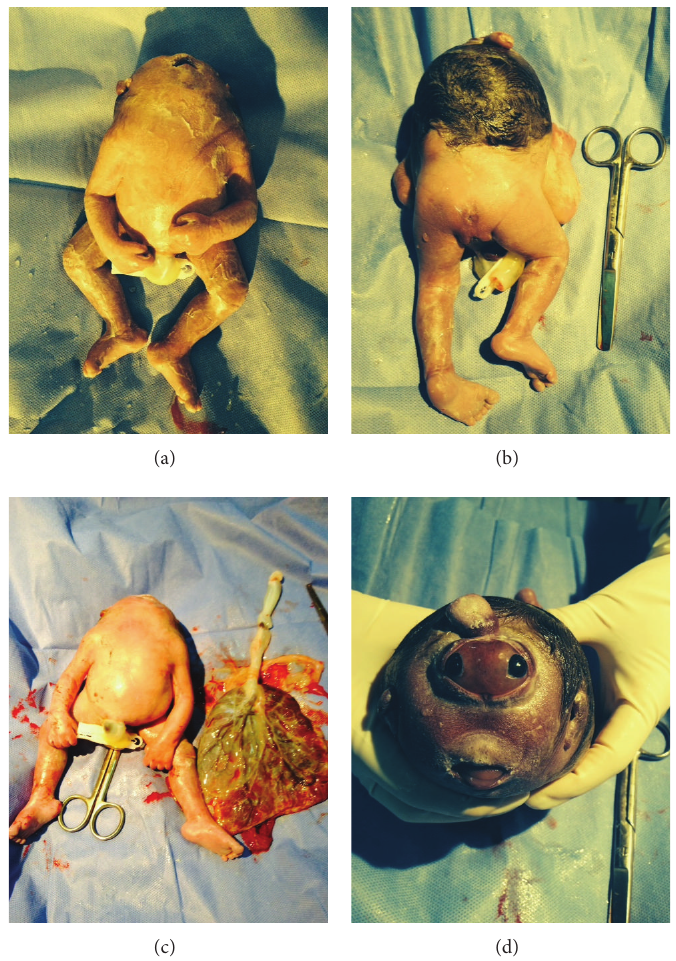
Figure 1: Cervicothoracal lordosis, iniencephaly, and